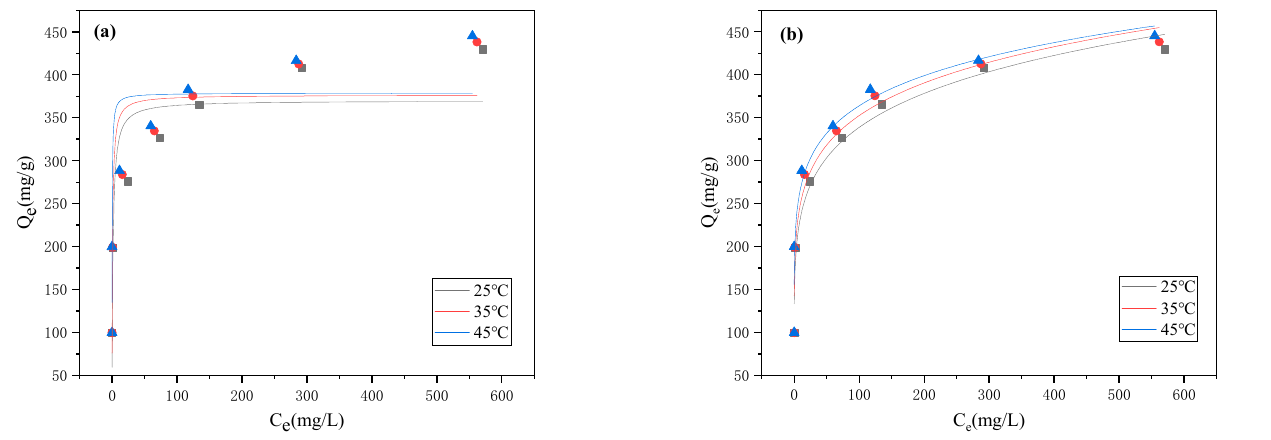
Figure 10. Langmuir adsorption isotherm ( a ) and Freundlich adsorption isotherm ( b ) of γ - Fe 2 O 3 @GMA@IM.